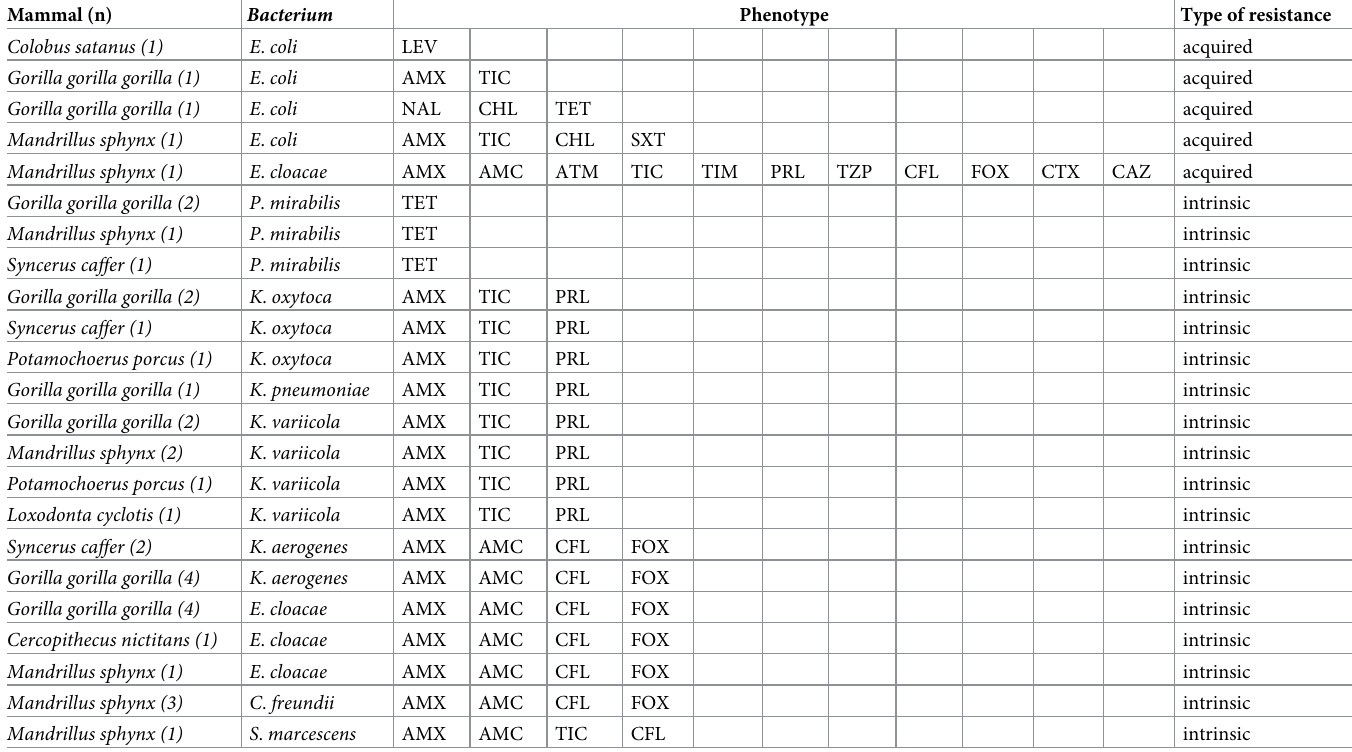
Table 1. The different antimicrobial resistance phenotypes in enterobacterial isolates from fecal samples collected in national parks of Gabon. Mammal (n)